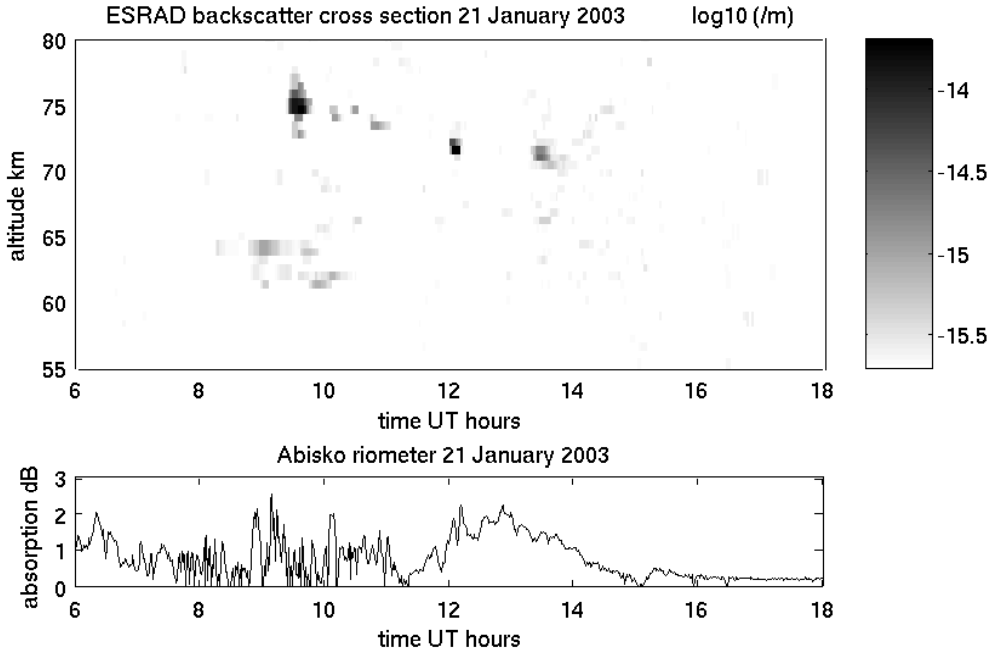
Fig. 2. Upper Panel: typical PMWE measured by the ESRAD 52MHz radar during the MaCWAVE campaign. This example shows radar observations 06:00–18:00 UT on 21 January 2003, with distinct echo layers visible between ∼ 08 UT and ∼ 16 UT. Lower panel: simultaneous cosmic noise absorption measured by the 30MHz riometer in Abisko, showing a signature typical of morning-side precipitation of high energy particles from the